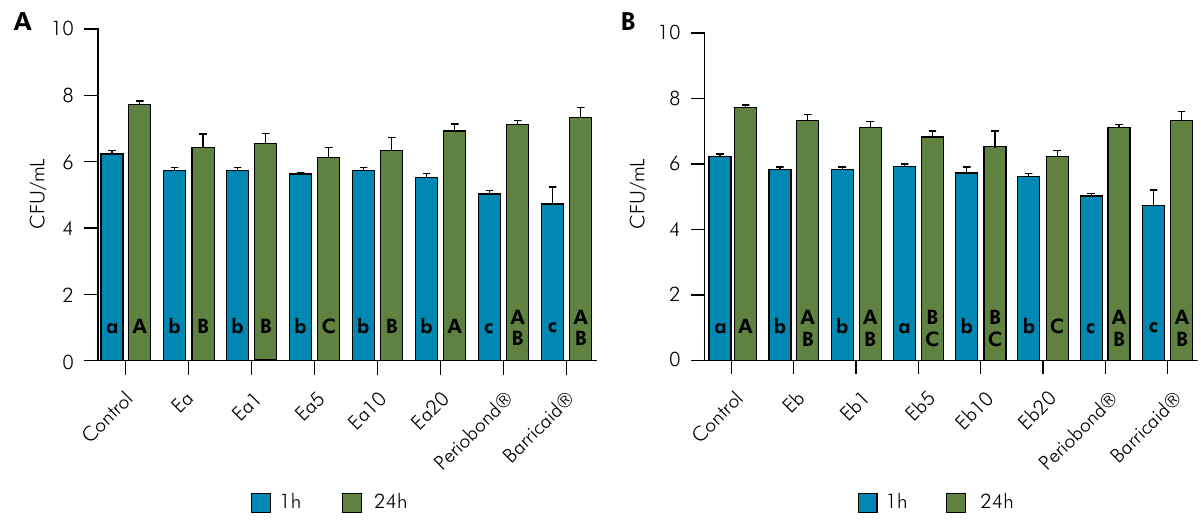
Figure 2. Modified direct contact test against E. faecalis at 1 and 24 hours. For each material (Ea or Eb), different lowercase letters indicate significant differences for CFU/mL at 1 h incubation (p < 0.05); different uppercase letters indicate significant differences for CFU/mL at 24 h incubation (p < 0.05); columns under the same horizontal line indicate no differences within the incubation time for each